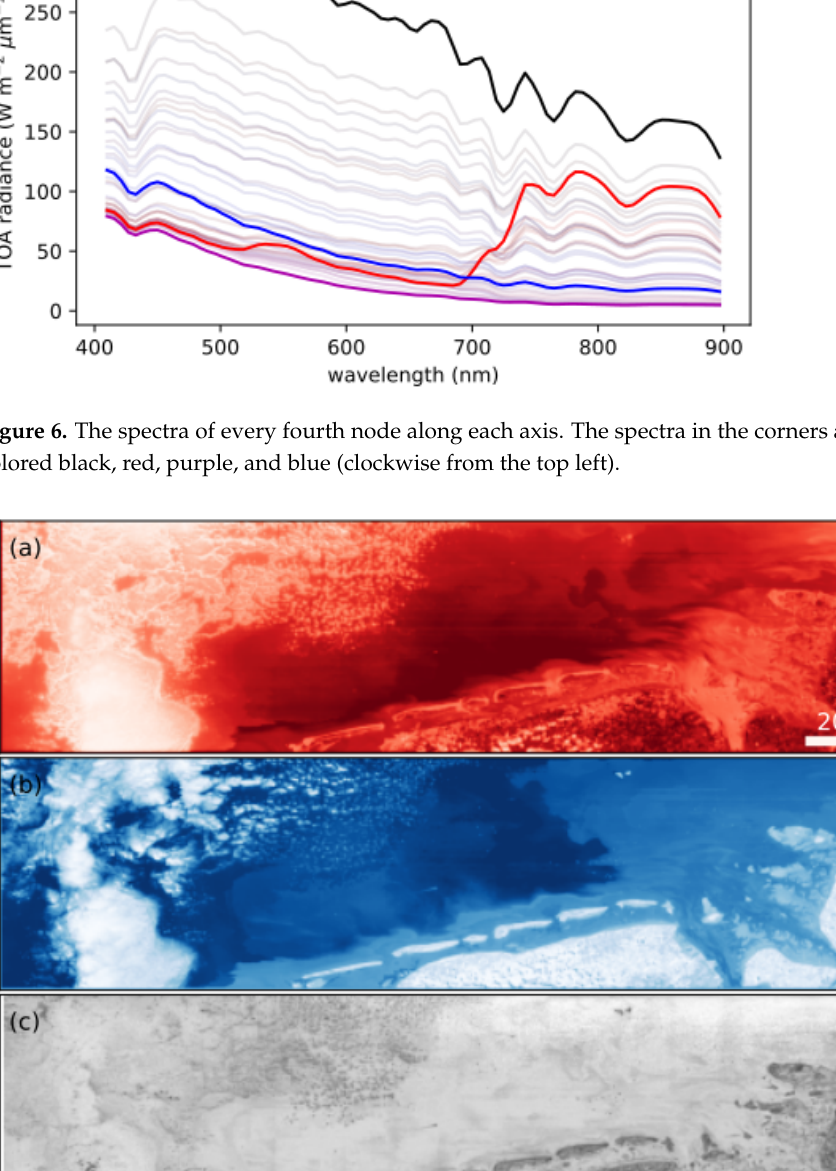
Figure 7. The first North Sea image classified according to the 64 ( b ) row of the BMU index. ( c ) the relative quantization